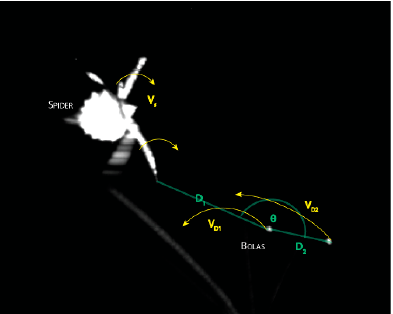
Figure 1. Tracking of Prey Capture Technique. Videos were tracked using Kinovea. Up to four locations were manually digitized for the position which was used to calculate the rotational velocity ( V ), period, and rotational diameter. The angle formed by the glue droplets was calculated over the course of the video using the law of cosines and the measured distances. The coordinate system is located below the spider perpendicular to the anchoring leg of the